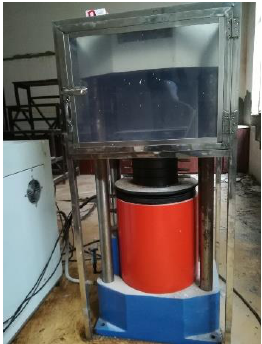
Figure 2. Electro-hydraulic servo compression testing machine.